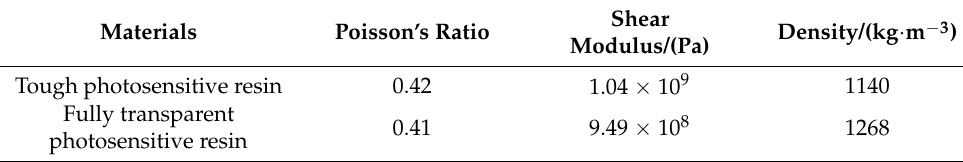
Table 1. Test materials intrinsic